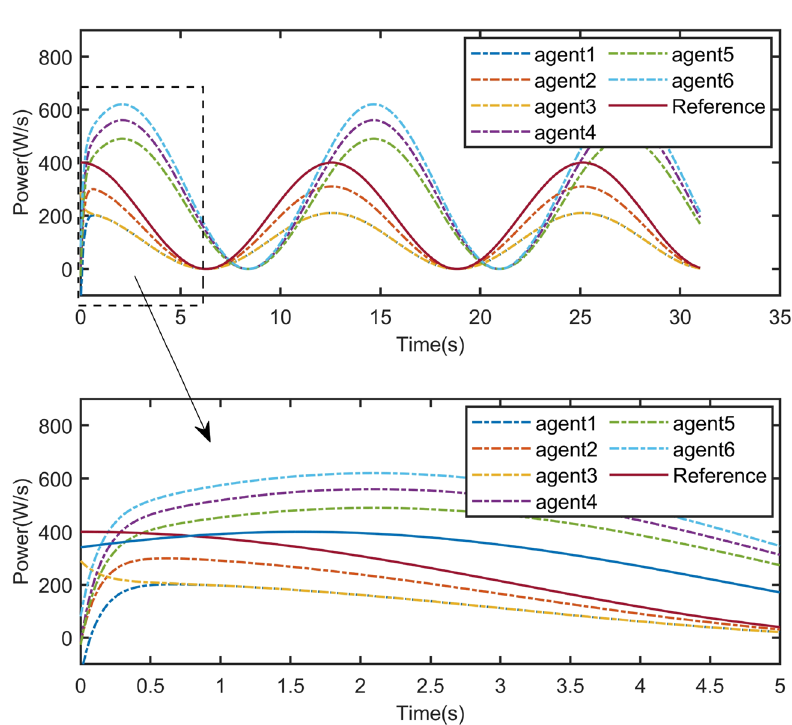
Figure 10: Consistent output of agent group power with expected power deviation.